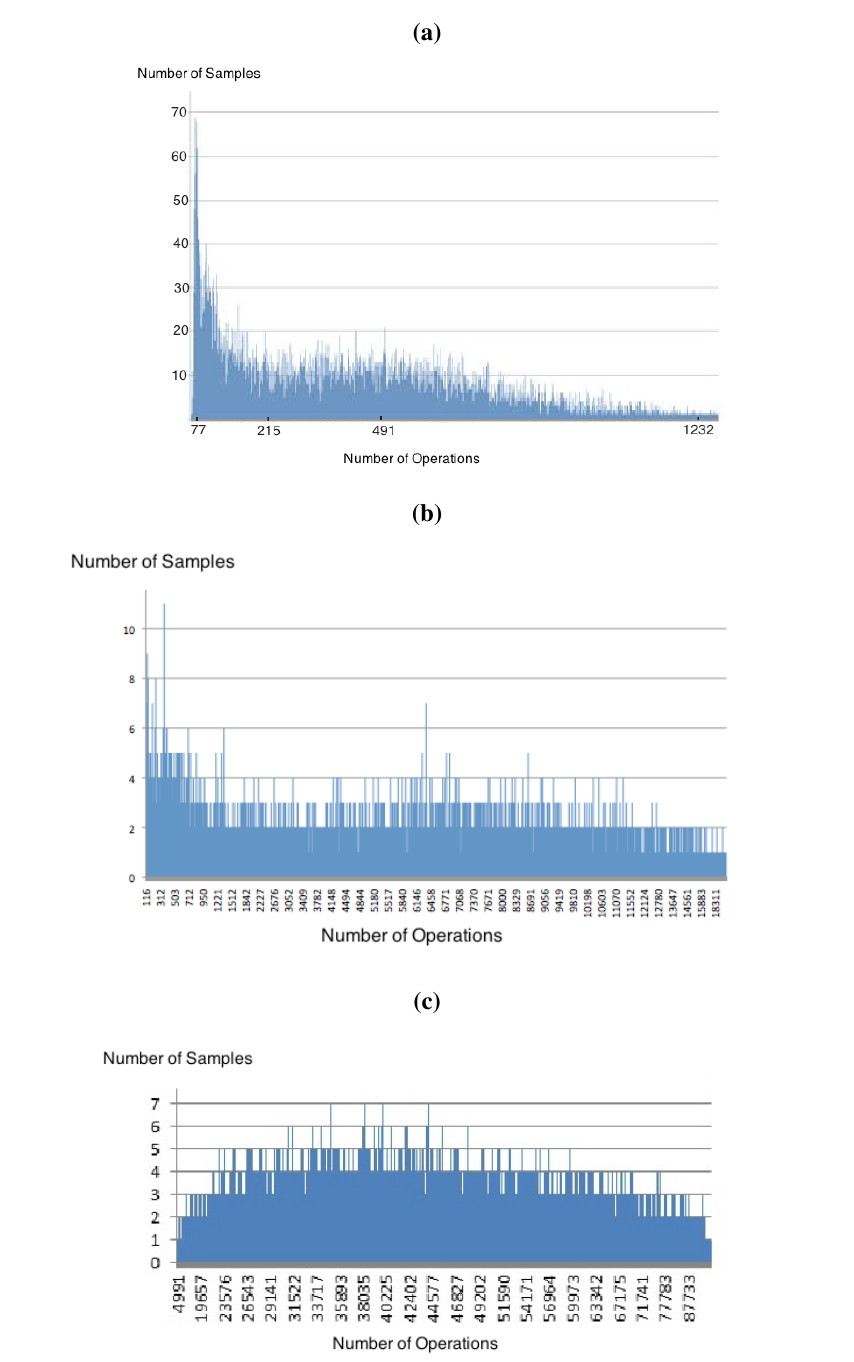
= 4.3 ). ( a ) Distribution found n = 4 . 3 n